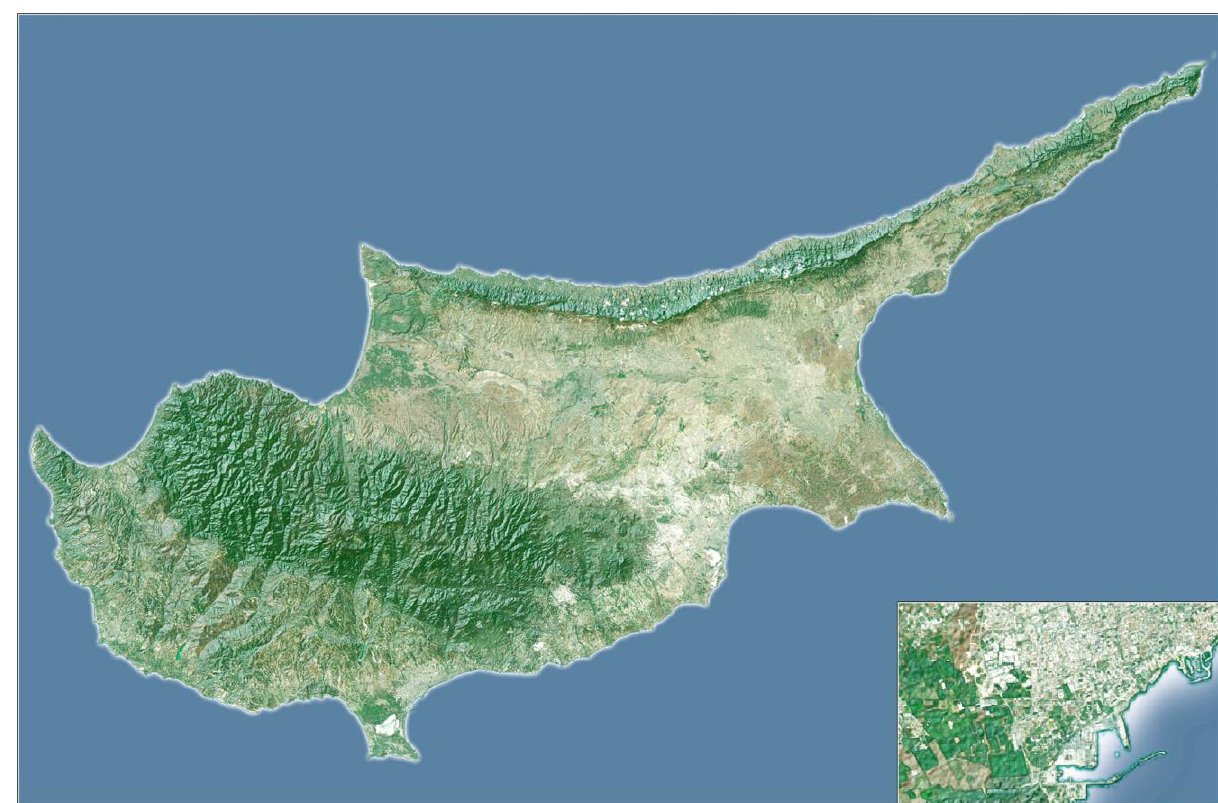
Figure 3. Composition of the COMPO_P image with SRTM-1. Note: fragment in full resolution in the inset